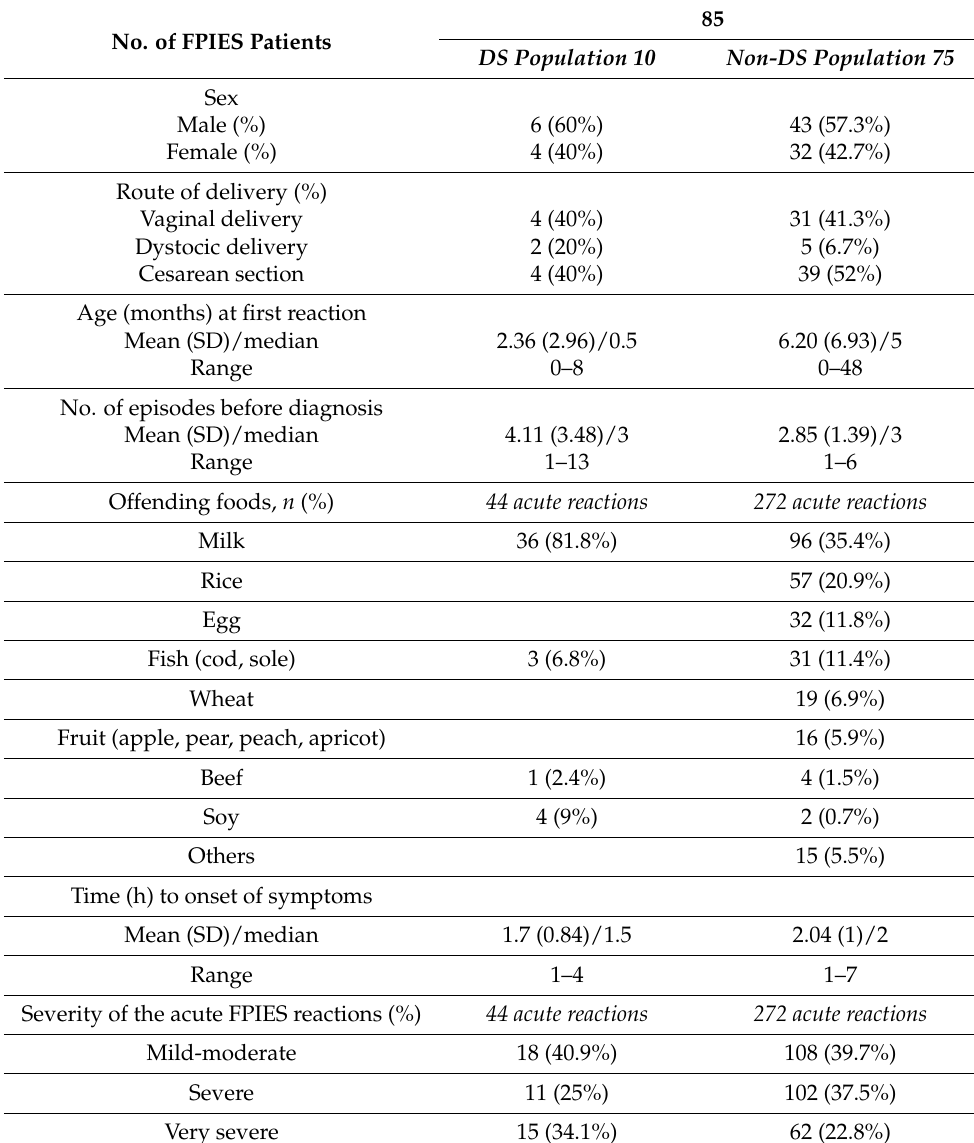
Table 1. Clinical characteristics of DS vs. non-DS patients with